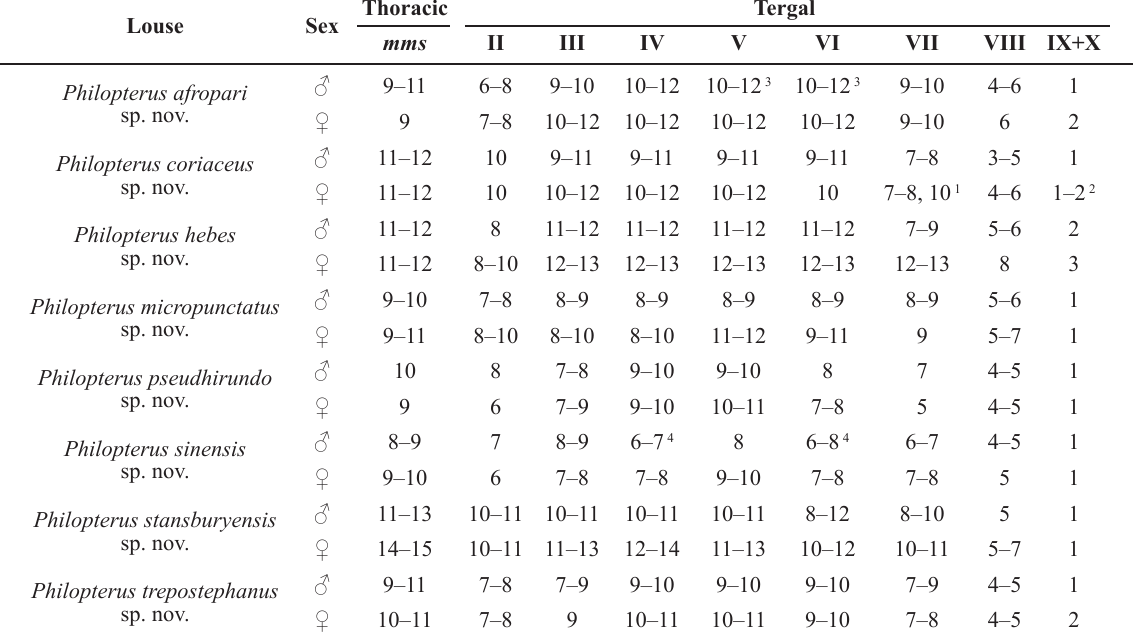
Table 2. Thoracic and abdominal chaetotaxy of the species of Philopterus Nitzsch, 1818 described in this paper. Only tergal seta are included here; for sternal setae, see Table 3; for pleural setae, see Table 4. Anterior margin of tergopleurite II has 1 seta on each side in all species, which is not listed in the table. Numbers denote the numbers of setae on one side of the abdomen only; for setal counts in the entire setal row of each segment, these numbers thus need to be doubled. Abbreviation: mms = marginal mesometathoracic